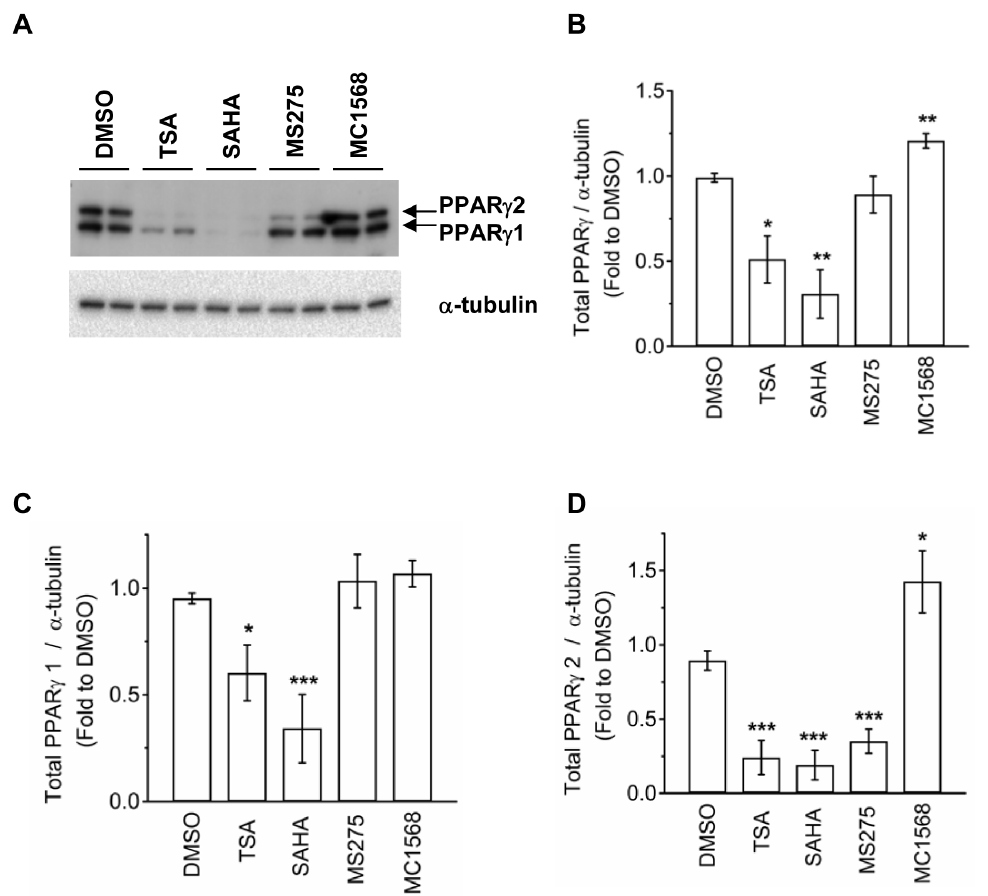
Figure 5. Effects of HDACI treatment on the levels of PPAR c expression. (A) 3T3-L1 adipocytes were treated with DMSO, 660 nM TSA, 20 m M SAHA, 10 m M MS275, or 5 m M MC1568 for 24 h. Cellular proteins were solubilized and subjected to SDS-PAGE and Western blot analysis with the indicated antibodies. Samples were treated in duplicate. Representative immunoblots from three independent experiments were shown in 5A. (B-D) Quantification data for total PPAR c (B), PPAR c 1(C), and PPAR c 2 (D) are shown. Asterisks denote significant differences compared with DMSO control (*p , 0.05; **p , 0.01; ***p , 0.001).